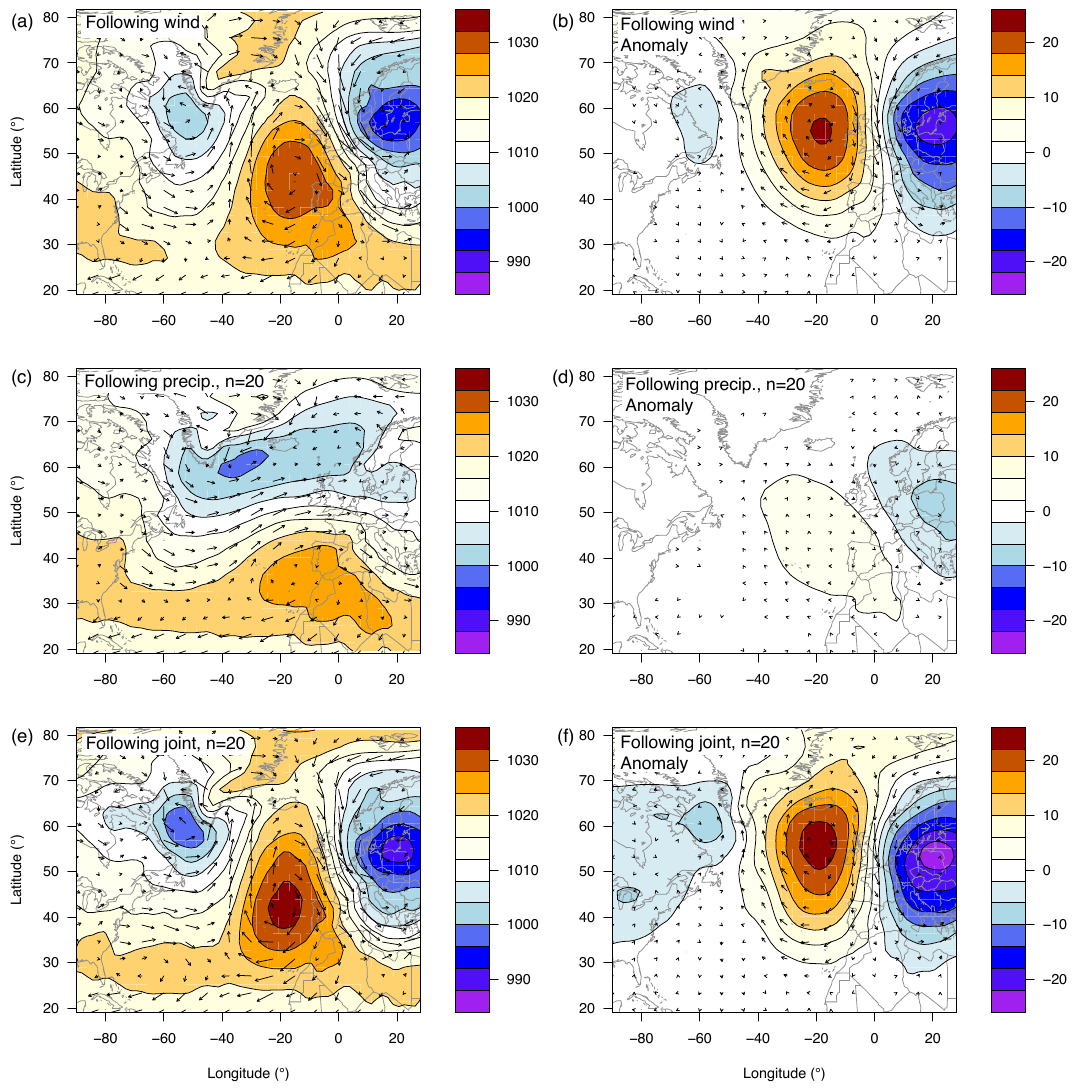
Fig. 7. (a) Composite satisfying North Sea wind criteria (459 entries) and its anomaly (b) with respect to full climatology (Fig. 6a). (c) Com- posite satisfying 20-day precipitation criteria (459 entries), for which the precipitation has fallen over the 20 days preceding the synoptic situation shown, and its anomaly (d) with respect to the full climatology in Fig. 6a. (e) Composite jointly satisfying the wind and 20-day sum precipitation criteria (15 events) and its anomaly (f) with respect to the full climatology in Fig.